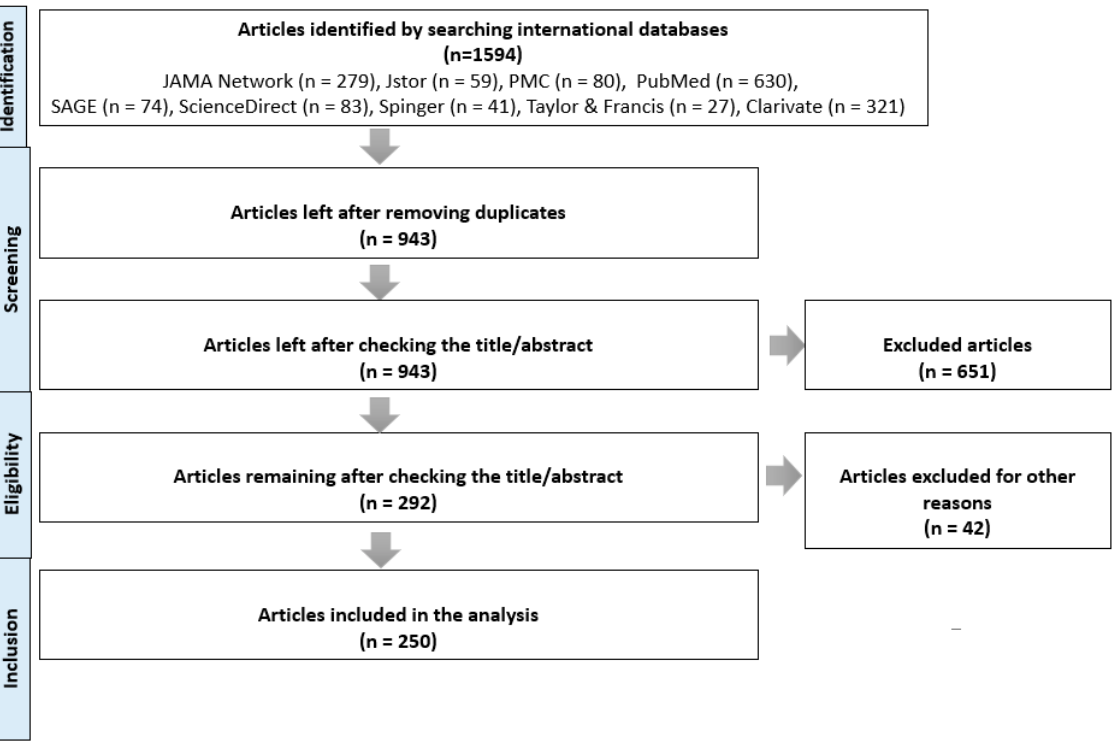
Figure 1. Research strategy applied for the selection of articles included in analysis.